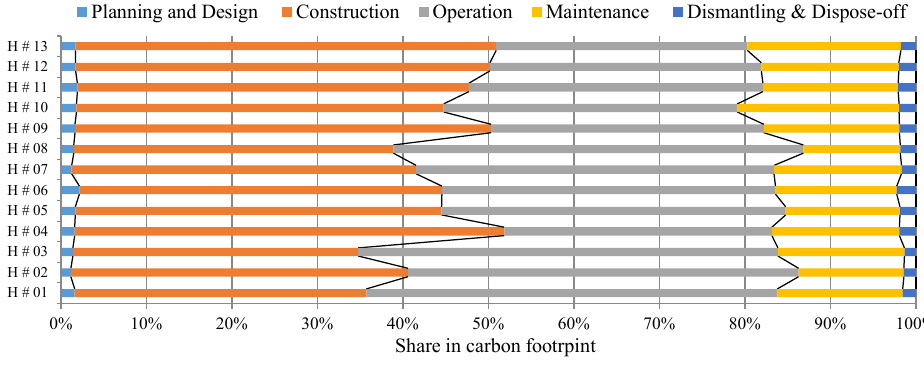
Fig. 6. Phase wise percentage contribution trend on individual basis.